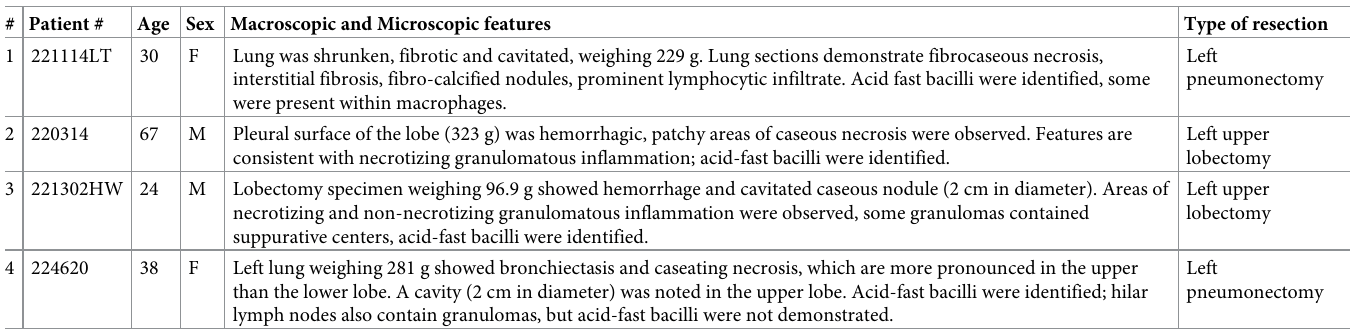
Table 1. Clinical characteristics of human